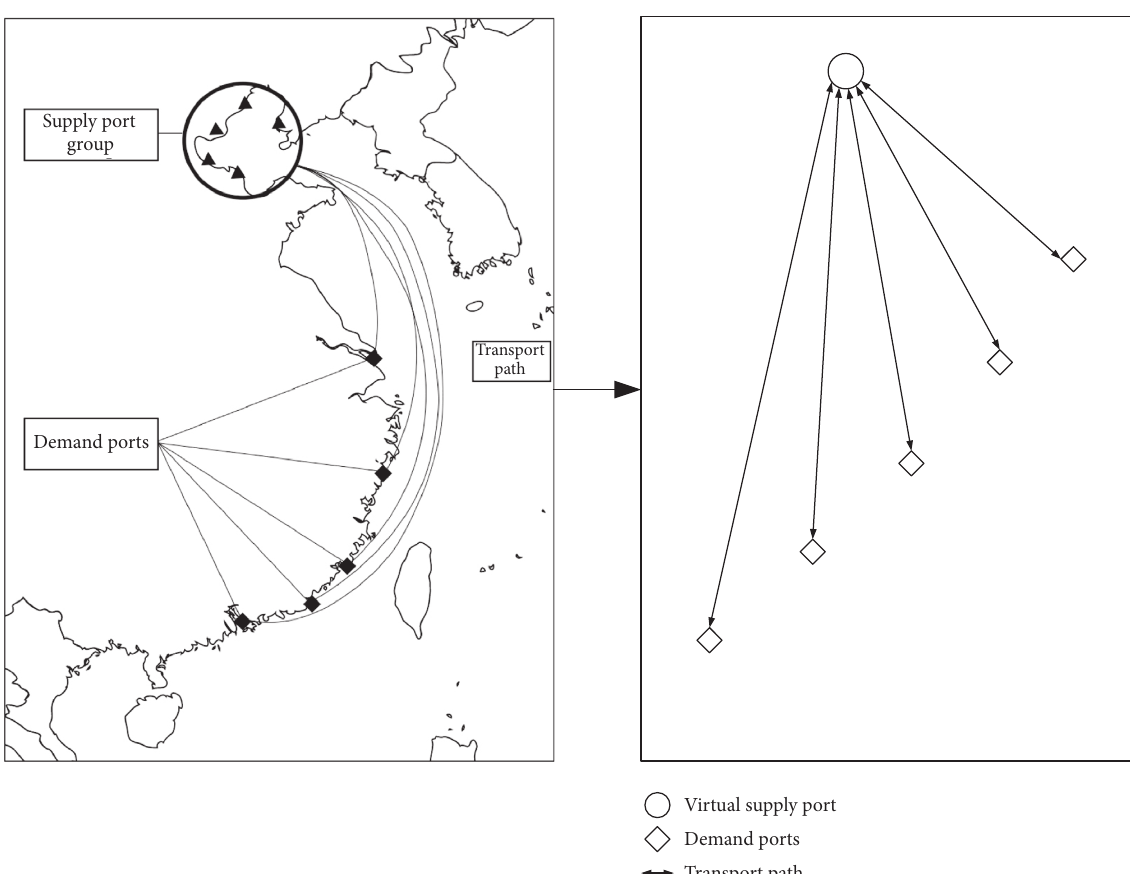
Figure 1: Distribution of electric coal loading and unloading ports and topology of the transportation